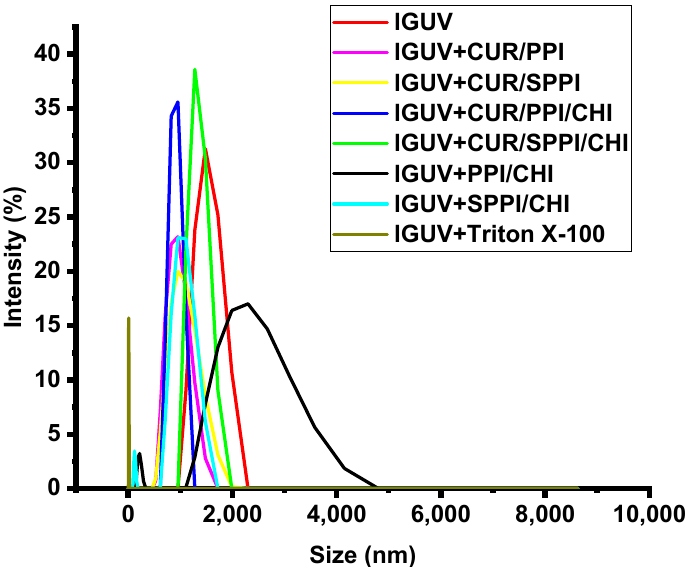
Figure 3. Dynamic light scattering size distribution curve of calcein-loaded giant unilamellar vesicles (lGUV), before and after interaction with hollow (PPI/CHI and SPPI/CHI) and curcumin-loaded protein nanoparticles (CUR/PPI, CUR/SPPI, CUR/PPI/CHI and CUR/SPPI/CHI) and Triton X-100.